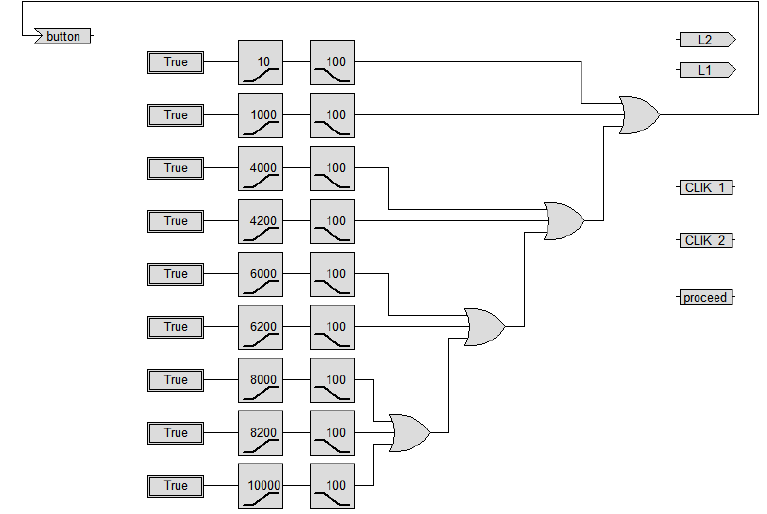
Figure 19. Transfer Function of the user Step, the only Step of the TUser Task.